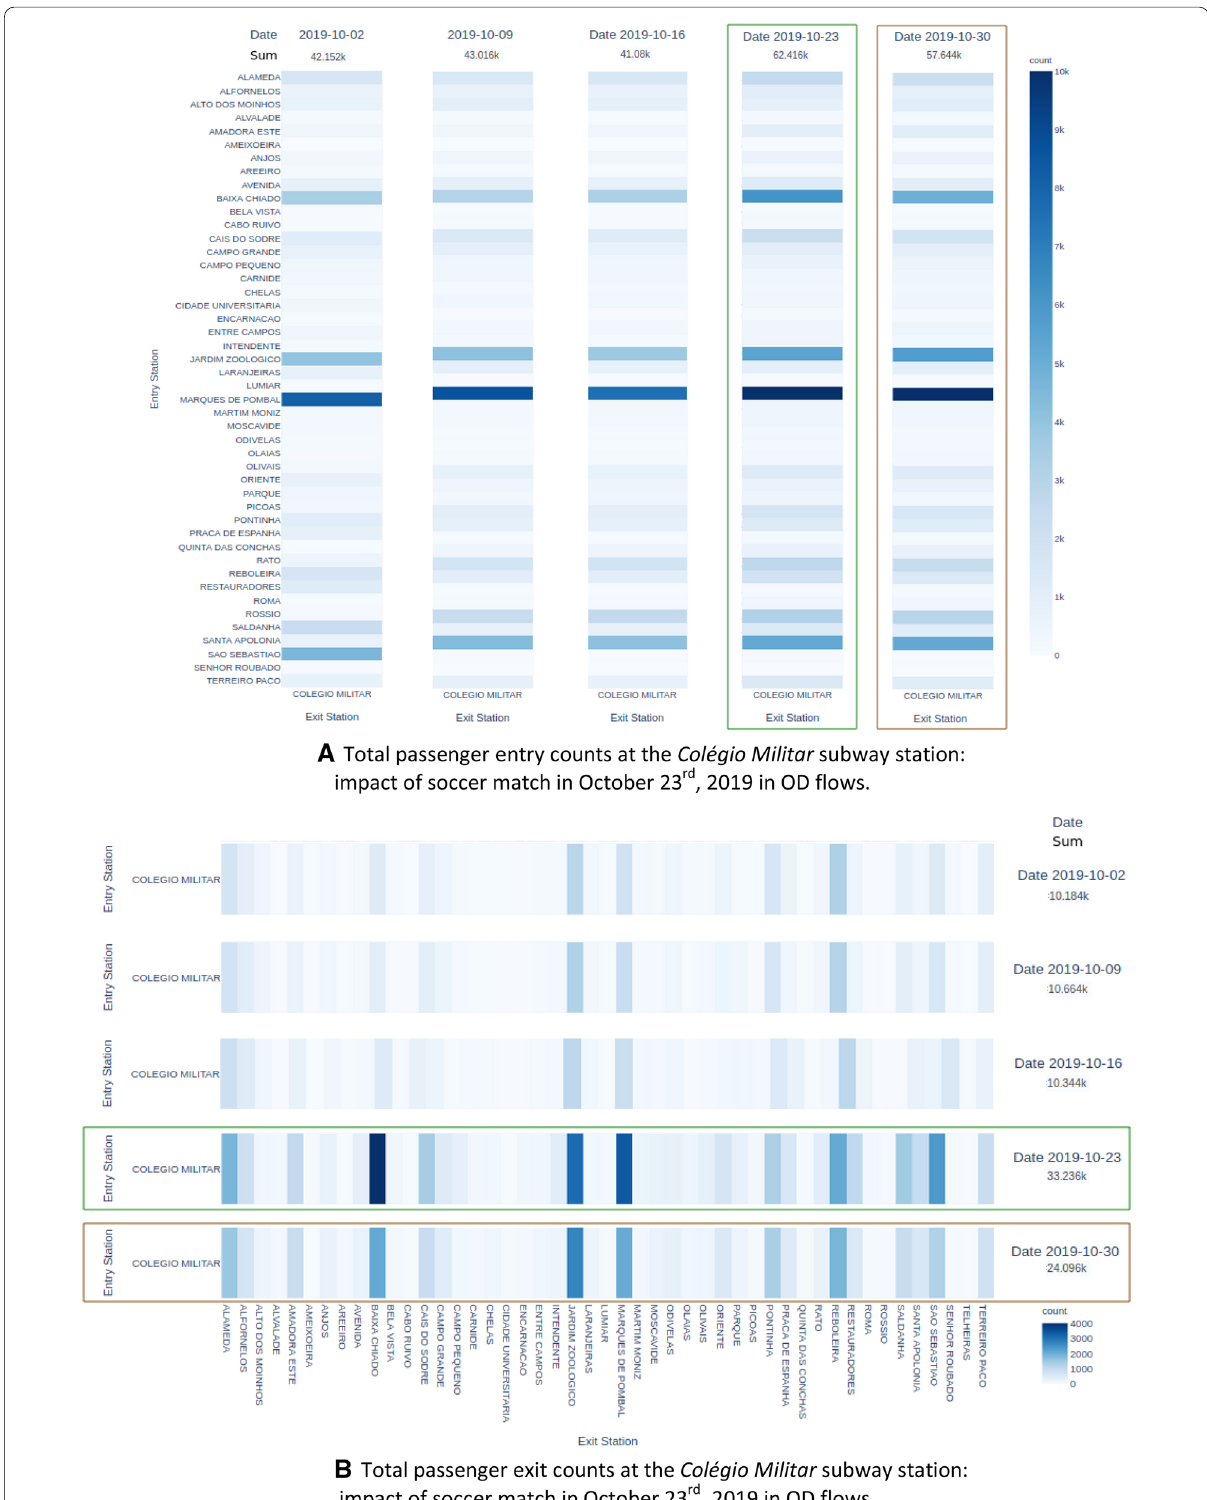
Fig. 7 a Total passenger entry counts at the Colégio Militar subway station: impact of soccer match in October 23rd, 2019 in OD flows. b Total passenger exit counts at the Colégio Militar subway station: impact of soccer match in October 23rd, 2019 in OD